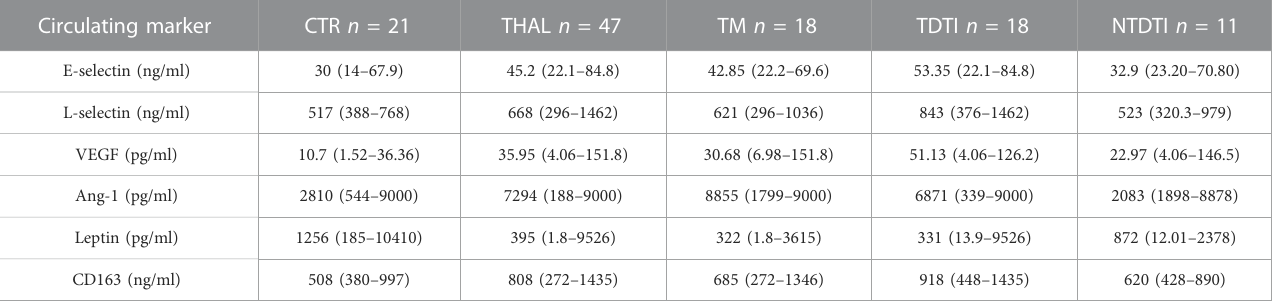
TABLE3Circulatinglevelsofadhesionmolecules,growthfactors,adipocytokinesandthemacrophageactivationmarkerinplasmafrompatientsandhealthysubjects. Data are reported as medians and range